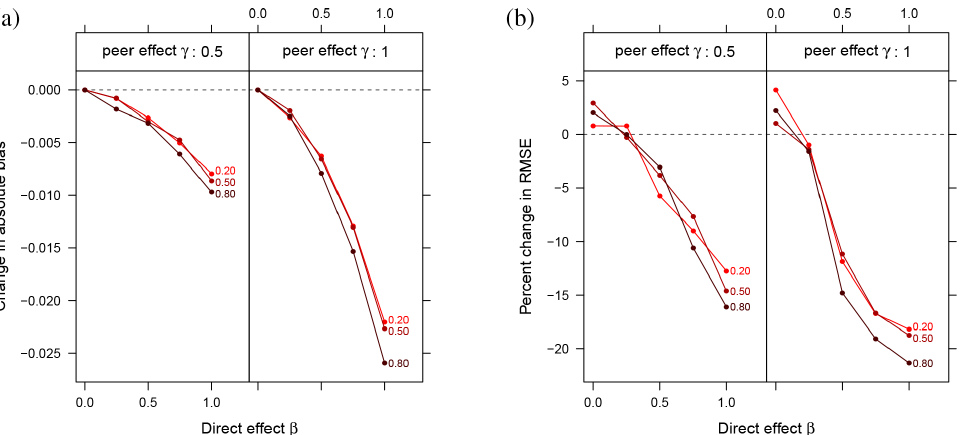
Figure 7 Change in (a) bias and (b) RMSE due to clustered random assignment. Lines are labeled with the expected pro- portion of edges that are within a community u . As before, results vary with the strength of the peer effect u , and the uuuu direct effect of the treatment u . The largest bias and error reductions here are not as substantial as the largest bias reduc- tions with small-world networks.